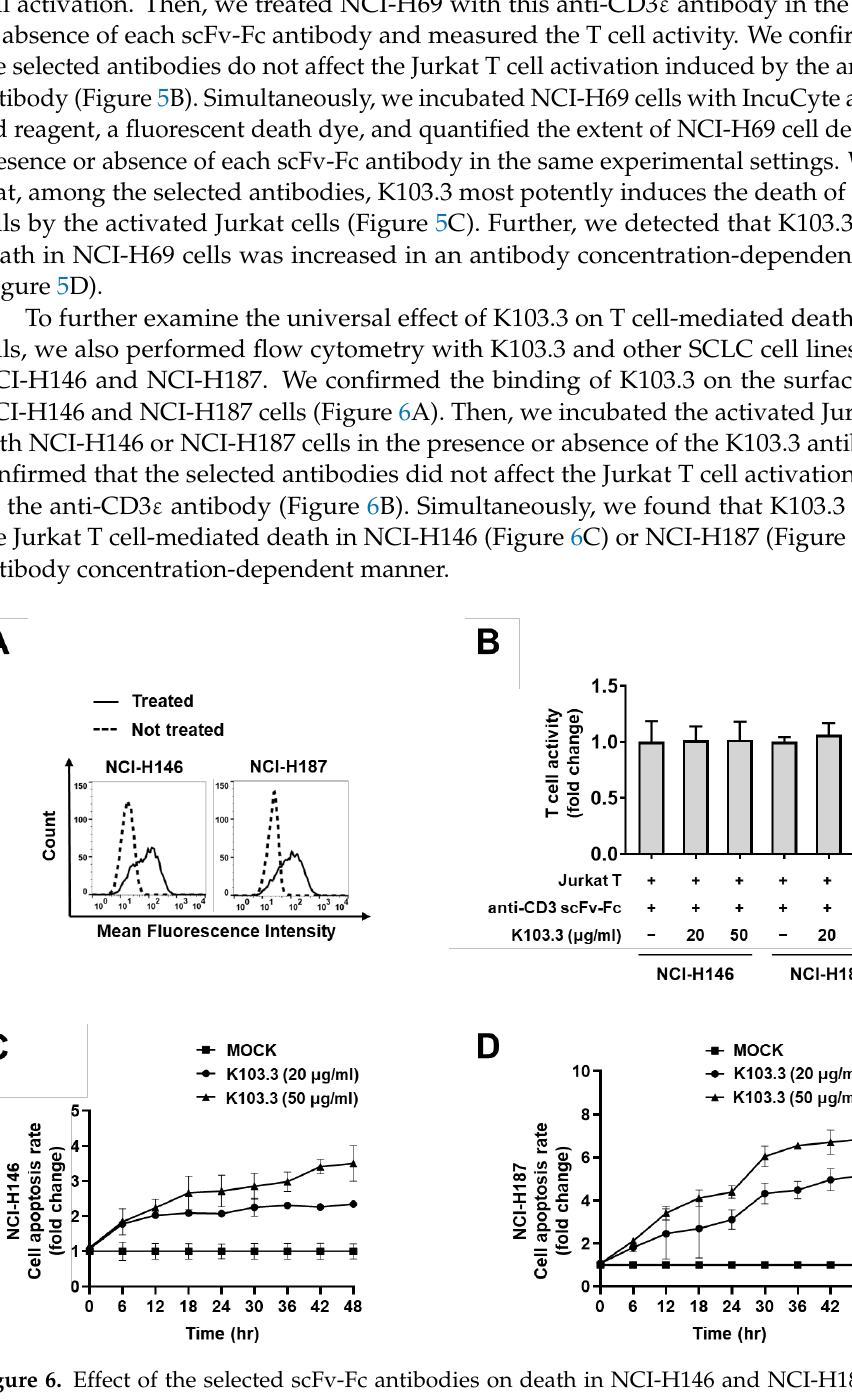
Figure 6. Effect of the selected scFv-Fc antibodies on death in NCI-H146 and NCI-H187 cells by activated Jurkat T cells. ( A ) The binding of the selected antibodies to MF-CADM1 on NCI-H146 and NCI-H187 cells were examined in the presence (solid line) or absence (dashed line) of the selected antibodies using flow cytometry. ( B ) T cell activity was compared by measuring the fluorescence of GFP expressed in activated Jurkat T cells in the presence or absence of selected antibodies. Antibody concentration-dependent death in NCI-H146 ( C ) and NCI-H187 cells ( D ) in the presence or absence of the selected antibodies was measured. All values represent the mean ± SEM of triplicate measurements from one of three independent experiments.